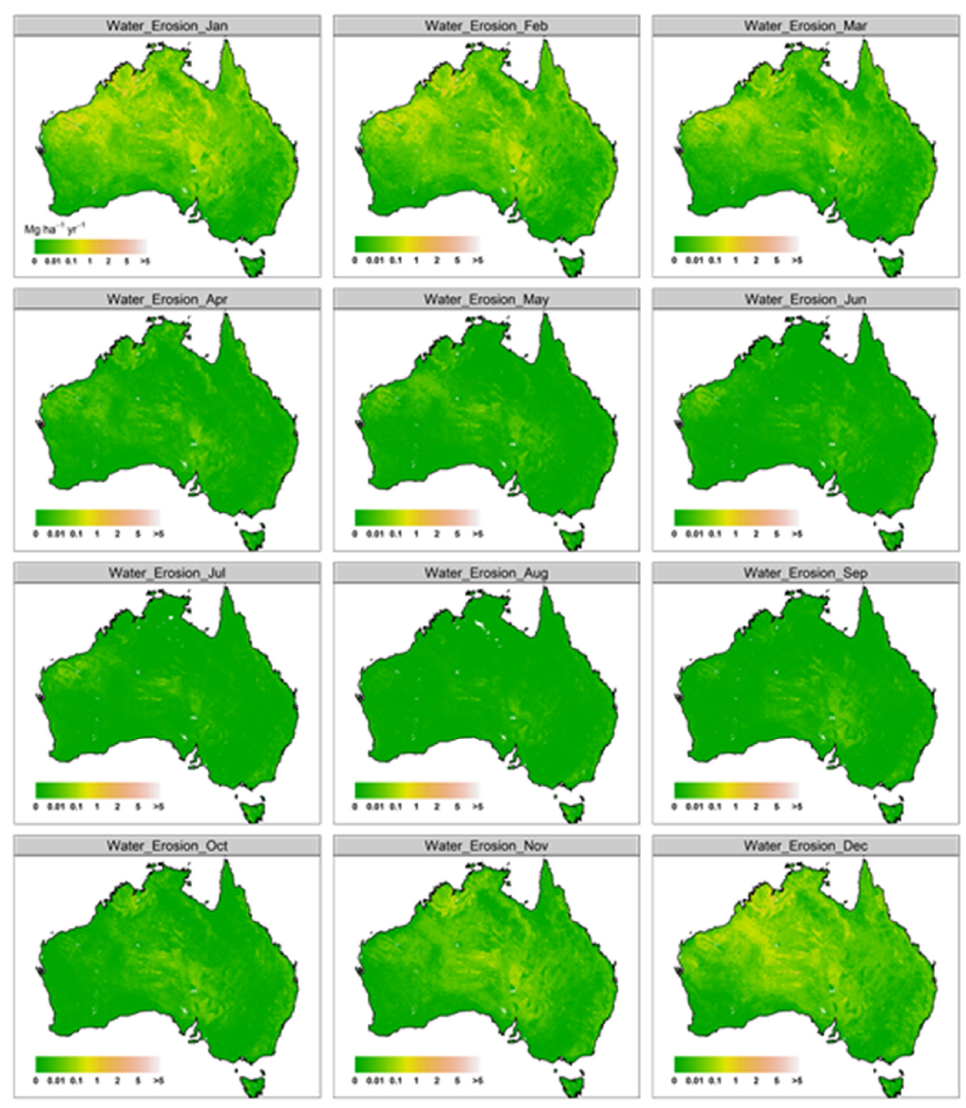
Figure 4. Monthly water erosion based on SILO in 2001–2020.